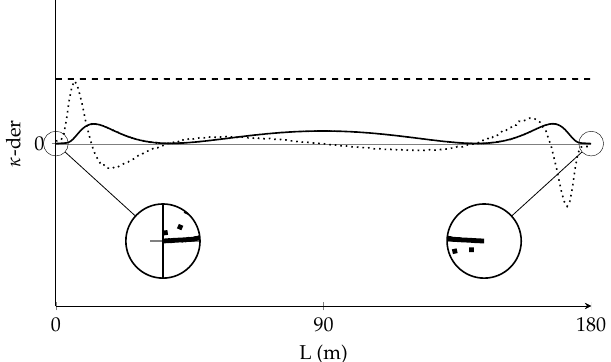
Figure 18. Plots of the 1st derivative of the curvature for the clothoid (dashed) and default ERB-function blending splines, with local Bézier curves, in [ p 1 , q 1 ] (solid), and the 2nd derivative of the curvature for the blending spline, scaled by 1 10 (dotted).